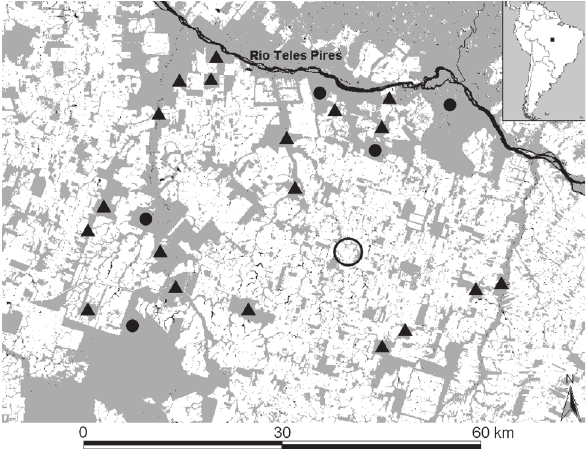
Figure 1. Location of the study area in Alta Floresta, northern Mato Grosso state, Brazil (see inset for location). A classified Landsat TM image (227/67, October 10, 2008) shows the 19 forest fragments (solid triangles) and five continuous forest sites (solid circles) sur- veyed by remote camera trapping in 2007-2009. The large open circle shows the location of Alta Floresta town. Grey, white and black areas represent forest, non-forest, and open-water cover,